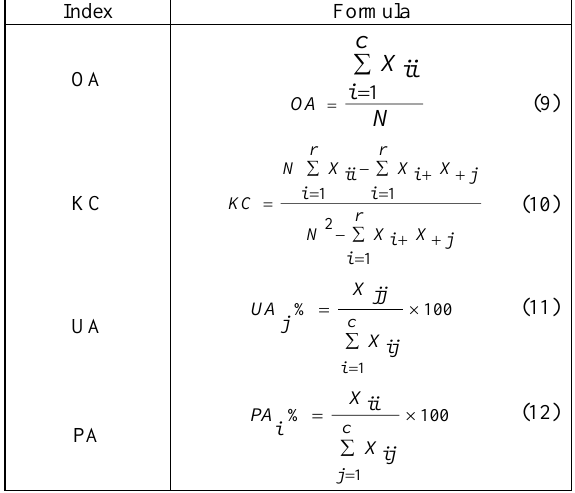
Table 2. Accuracy evaluation benchmarks from